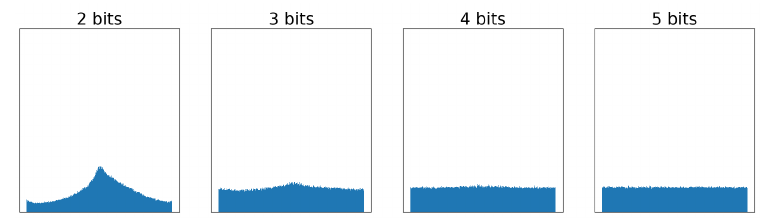
Figure 1. Weight quantization error histogram for a range of